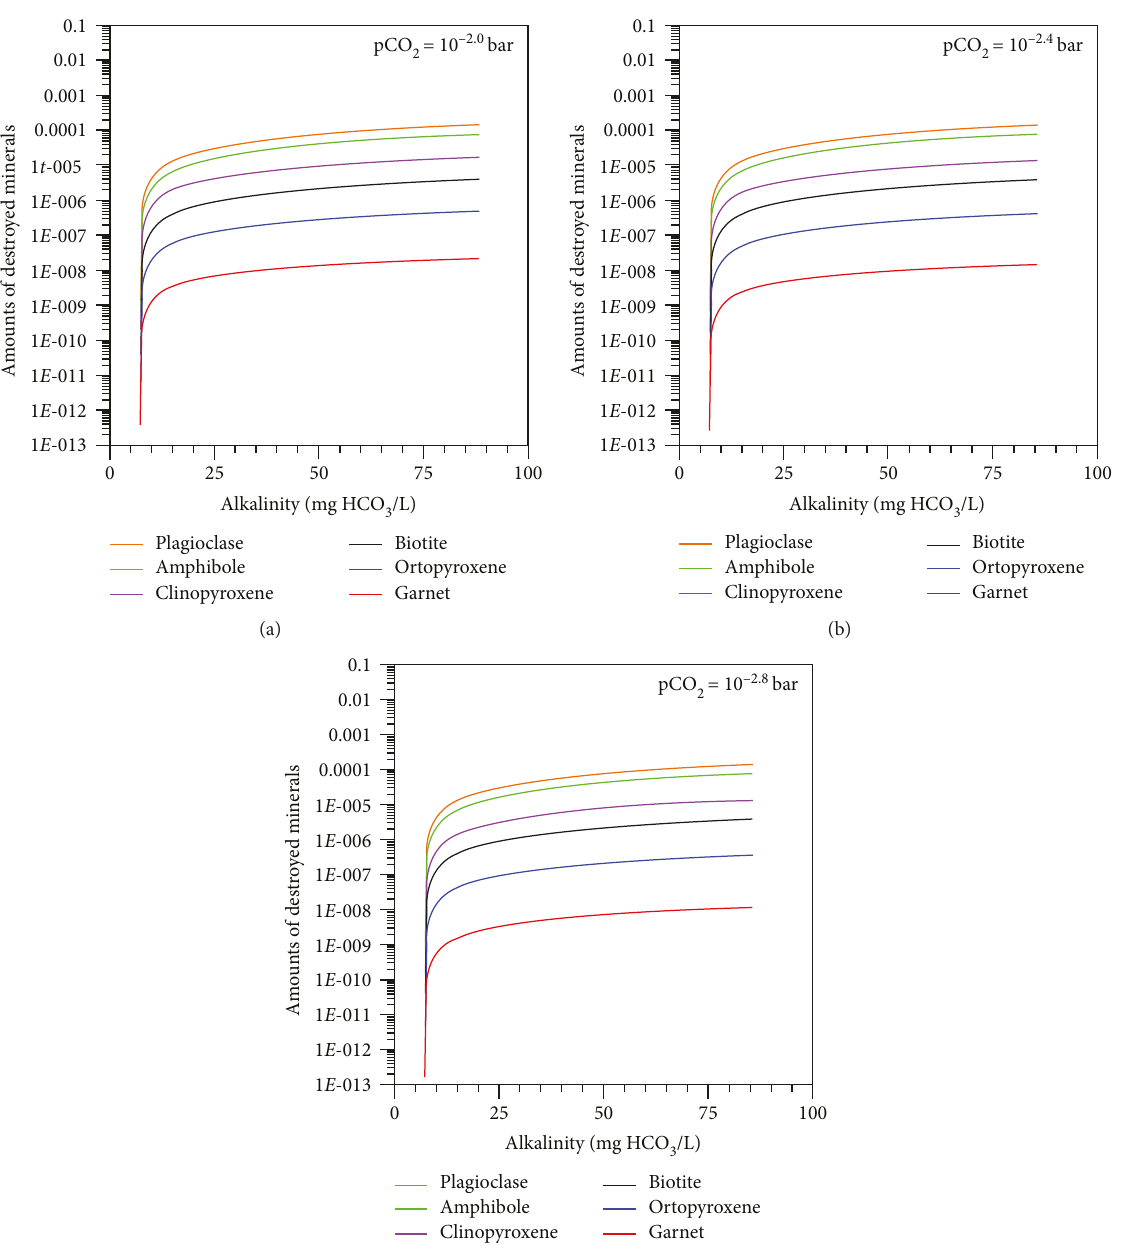
Figure 5: Moles of destroyed solid reactants against alkalinity, showing the results of reaction path modeling for the dissolution of granulite: (a) pCO of 10 -2.0 bar, (b) pCO of 10 -2.4 bar, and (c) pCO of 10 -2.8 2 2 2